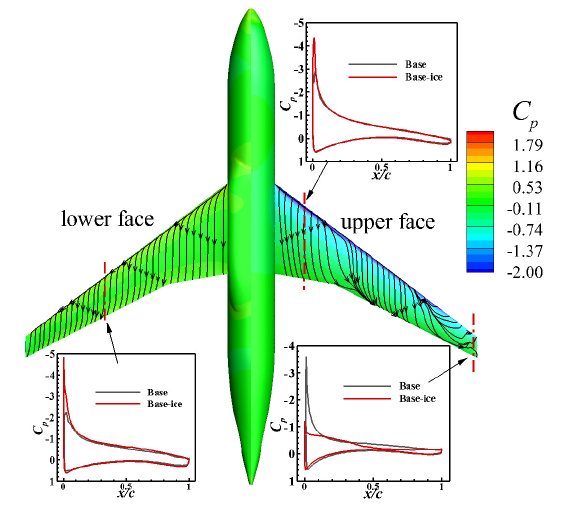
Figure 10. Flow field changes of Base before and after ice